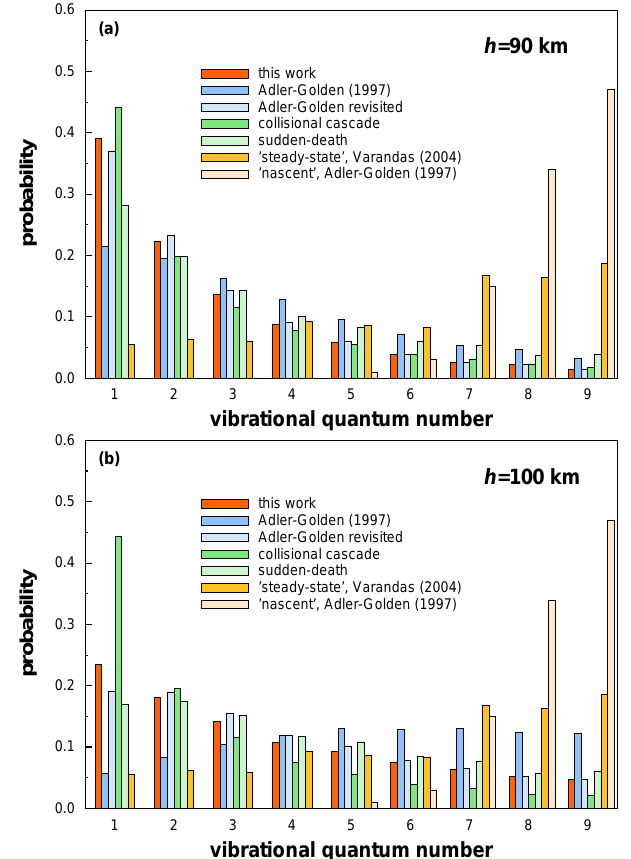
Fig. 2. Vibrational distributions of the hydroxyl radical at (a) 90km and (b) 100km. Also shown for comparison based on the same set of concentrations and rate-constants are: Adler-Golden (1997) re- sults using his estimate for the O + OH ( v ) total rate constant; Adler- Golden scheme revisited using the effective rate constant based on this work; McDade and Llewellyn (1987) ‘sudden-death’ and colli- sional cascade. Also included is other theoretical data of Varandas (2003) and the ‘experimental’-renormalized nascent distribution in Reaction (R8) of Charters et al. (1971).